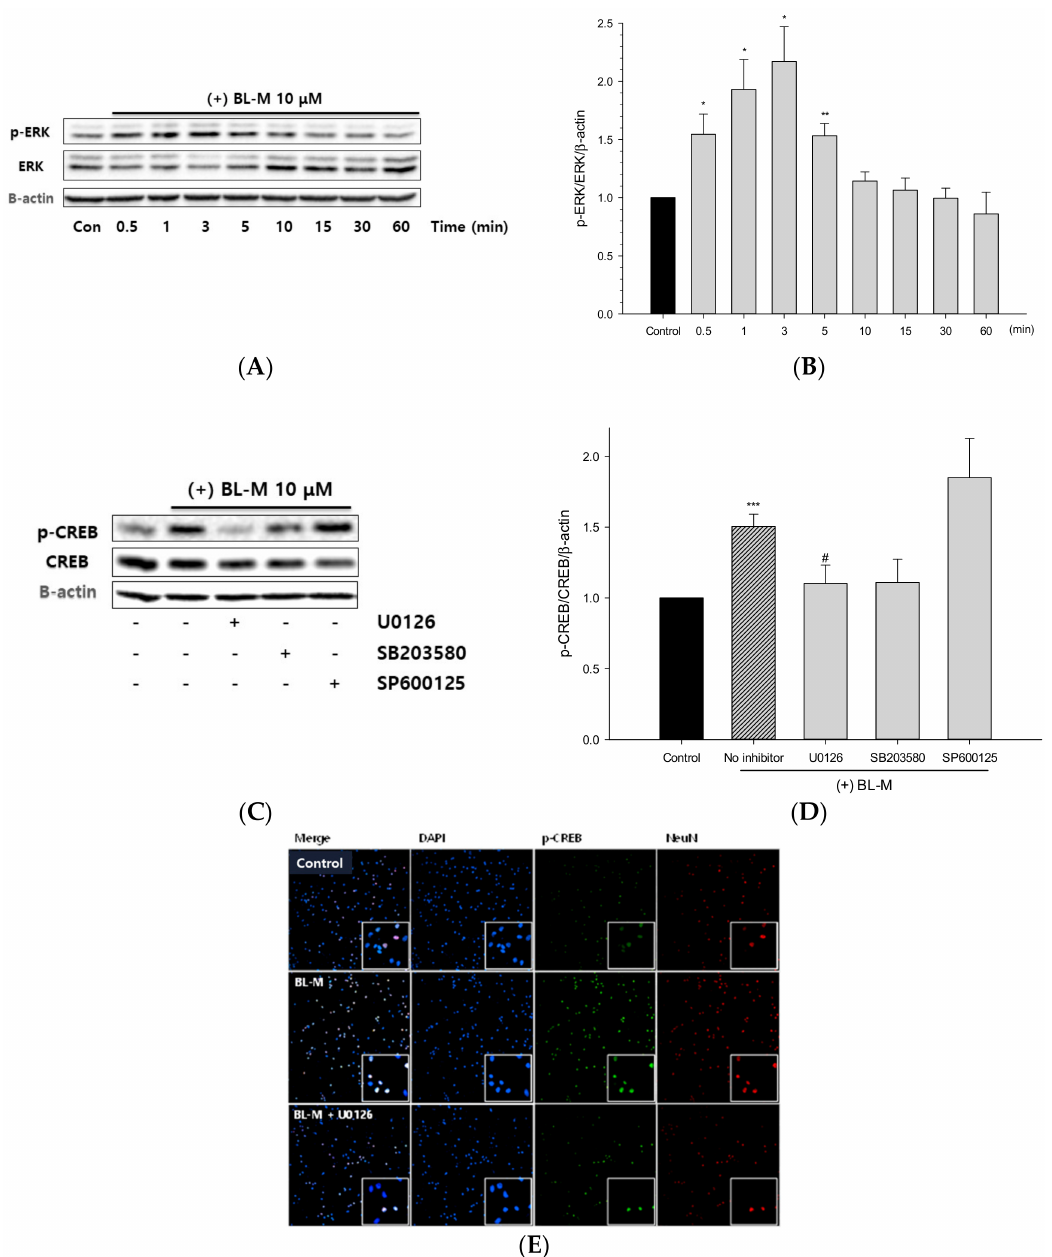
Figure 7. ERK1/2-mediated CREB phosphorylation by BL-M in primary cultured rat cortical cells. Cells (10–11 days in vitro) were treated with BL-M for the indicated periods of time, and the cell lysates were analyzed by Western blotting using phospho-ERK1/2 antibody, as described in the Section 4 ( A ). Total ERK1/2 and β -actin were used for loading control. The quantitative analysis was expressed as relative changes with respect to the control group ( B ). The levels of CREB phosphorylation in the cells pretreated with kinase inhibitors were analyzed by Western blotting with a primary antibody of anti-phospho-CREB (Ser133) ( C ), and quantitatively expressed as relative changes with respect to the control group ( D ). Each data represents the mean ± S.E.M. from at least three independent experiments. Representative images of immunocytochemical staining conducted in the cells pretreated with U0126 using phospho-CREB antibody are shown ( E ) (* p < 0.05, ** p < 0.01, *** p < 0.001 vs. control; # p < 0.05 vs. BL-M treated